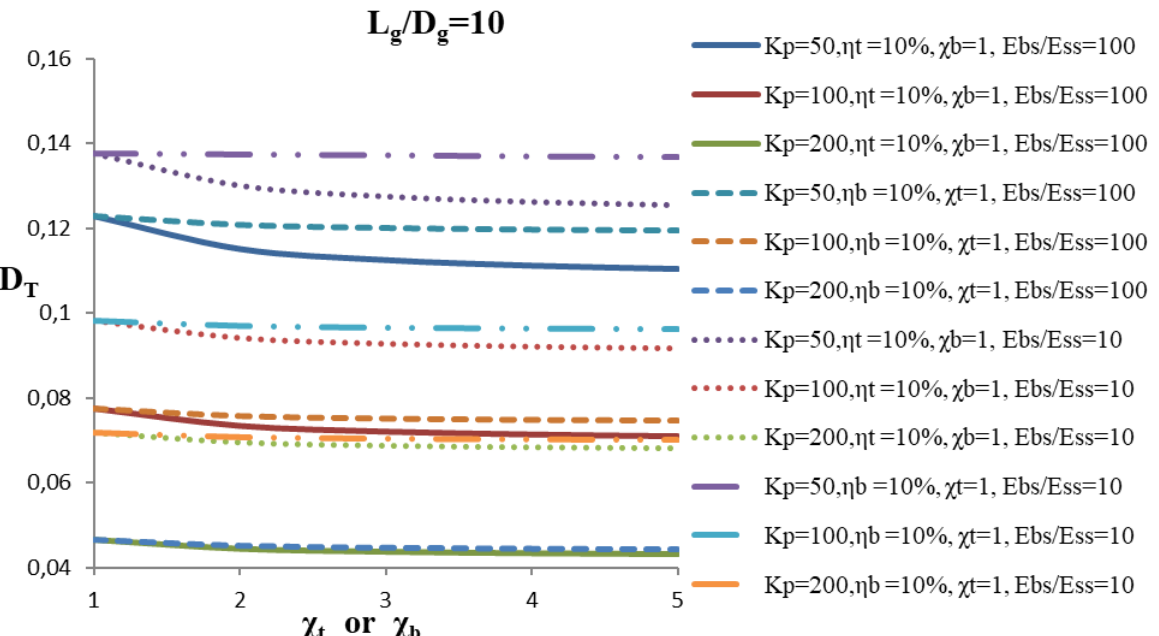
, or strengthening t